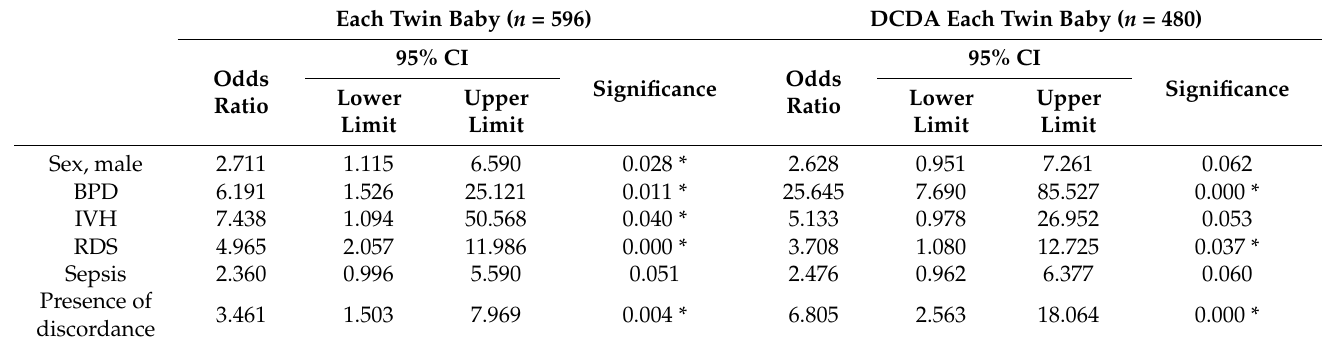
Table 5. Multiple regression analysis for the risk factors predictive of neurodevelopmental delay 1 year after